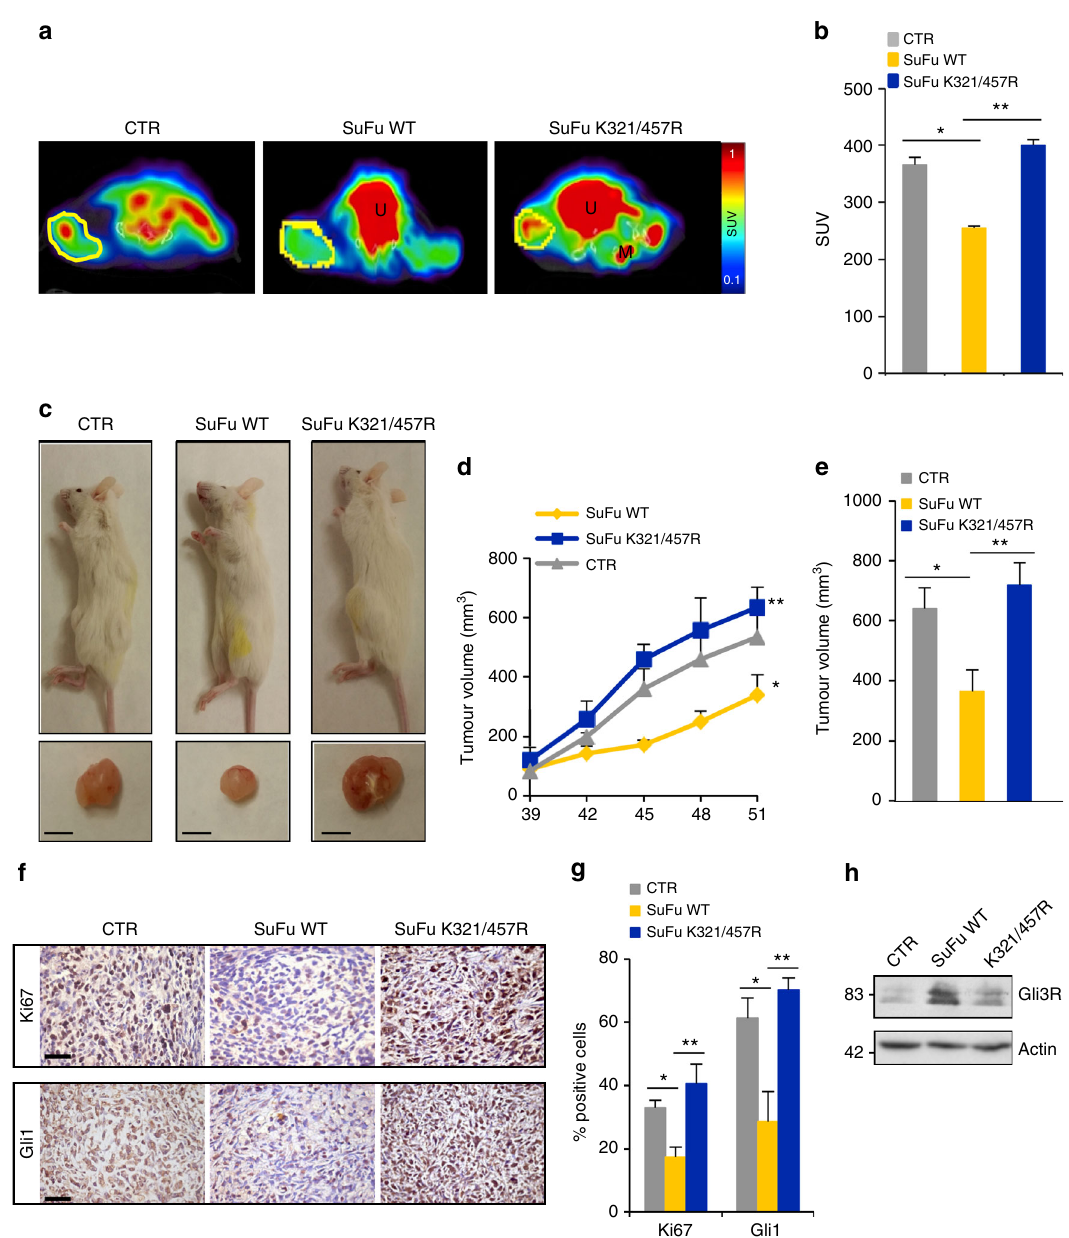
Fig. 6 Human Daoy MB xenografts. a PET/CT images of representative CTR ( n = 6), SuFu WT ( n = 6), and SuFu K321/457R ( n = 8) mice showing tumour FDG (F-18- fl uorodeoxyglucose) uptake at 41 days after implantation. ROI (region of interest) drafts the tumour mass. Signi fi cant differences were observed between SuFu WT and SuFu K321/457R mutant mice. U urinary bladder, M femoral muscle. b Graphic representation of SUV (standard uptake value). For each tumour, the SUV as mean tumour FDG uptake normalised for animal body weight was calculated. Signi fi cant difference in tumour FDG uptake was observed between SuFu K321/457R and SuFu WT mice. *P < 0.05, SuFu WT versus CTR; * *P < 0.05, SuFu K321/457R versus SuFu WT. c Images of xenografted NOD/SCID mice with bilateral MB xenograft tumours. Tumour volume in SuFu K321/457R mutant mice is visually bigger than SuFu WT (scale bars = 5 mm). d Tumour volumes were monitored over time by caliper measurements at the indicated times. *P < 0.01, SuFu WT versus CTR; * *P < 0.01,